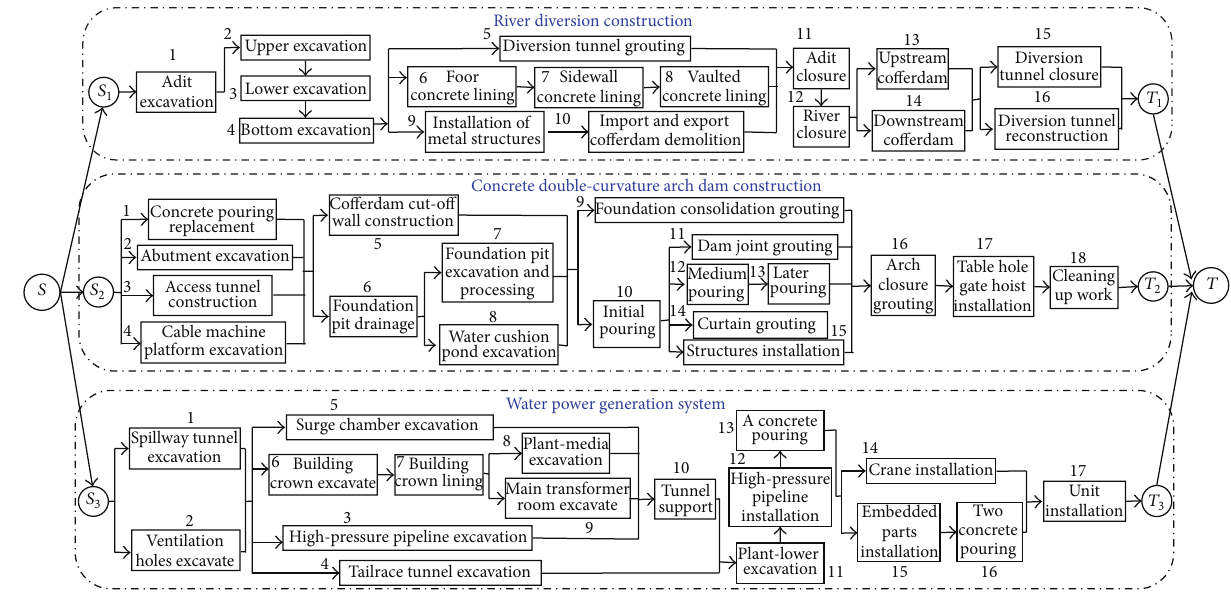
Figure 6: Detailed information of hydropower construction project 𝑋 .